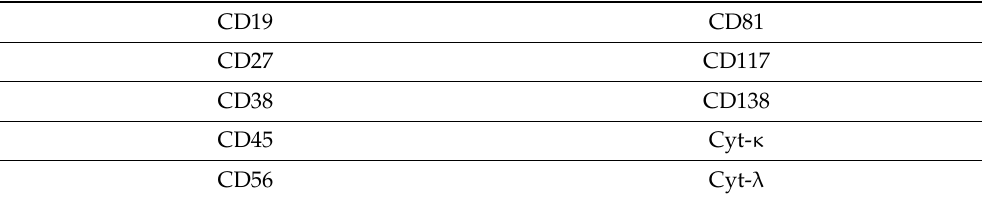
Table 2. EuroFlow antibody panel